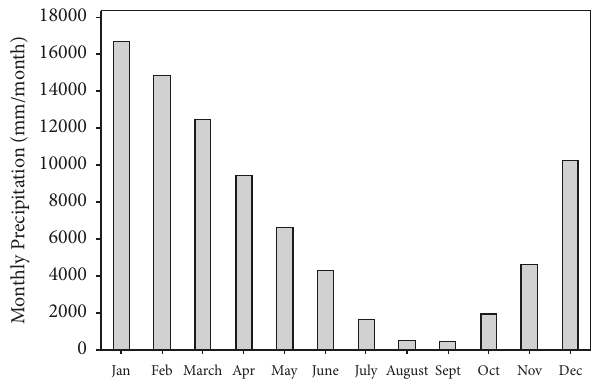
Figure 2: Monthly rainfall pattern observed from the Juanda Meteorological Station.